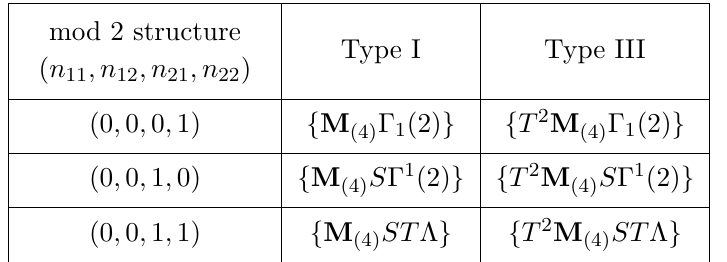
Table 11 . Classification of Types I and III for D = 4 .